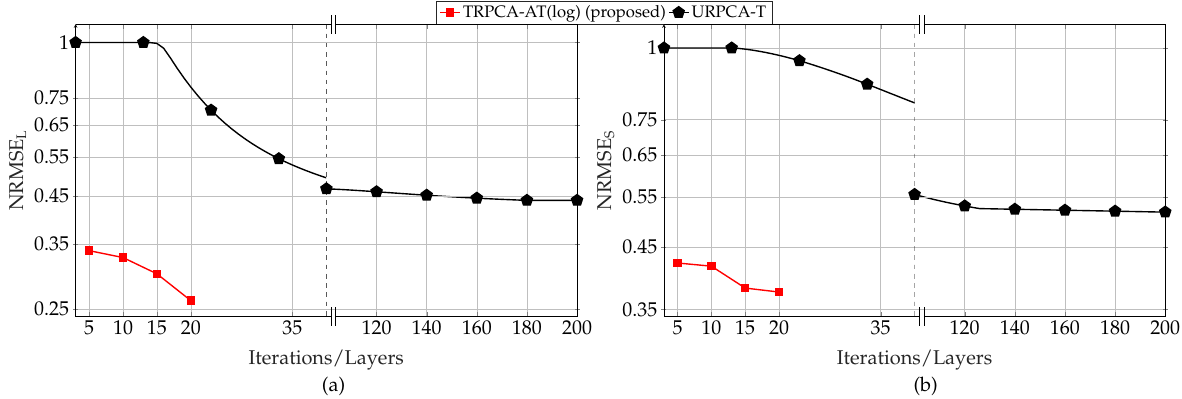
Figure 15. Average NRMSE of low-rank ( a ) and sparsity ( b ) contributions of SFCW Radar model for K / MN = 20% with M = N = 100 for the proposed ADMM-based trained RPCA with adaptive thresholding based on logarithm heuristic (TRPCA-AT(log)) and ADMM-based untrained RPCA with thresholding